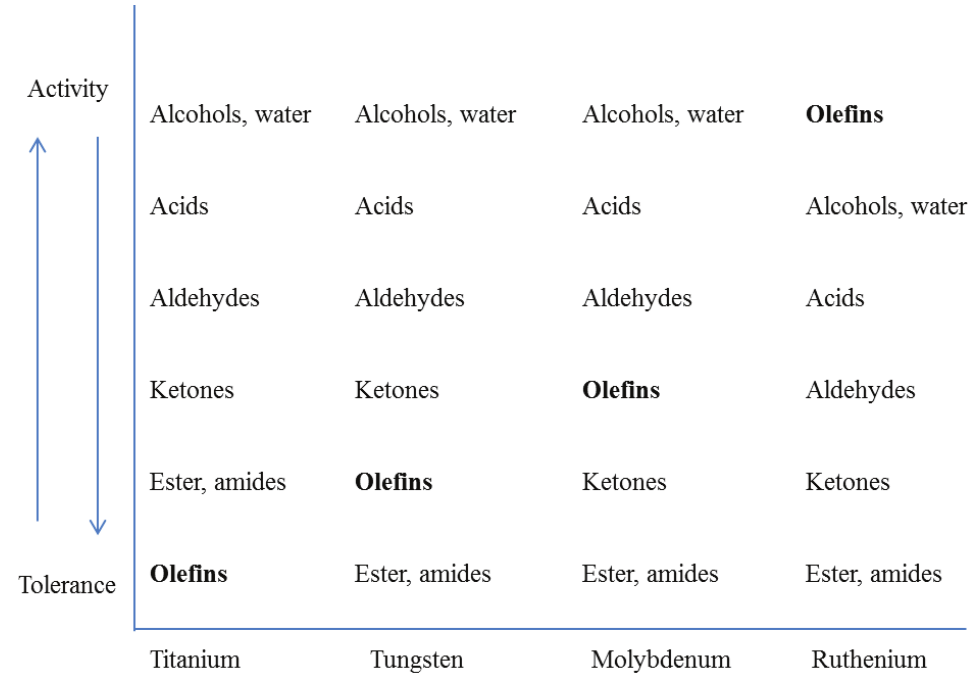
Figure 56. The reactivity/tolerance of metathesis